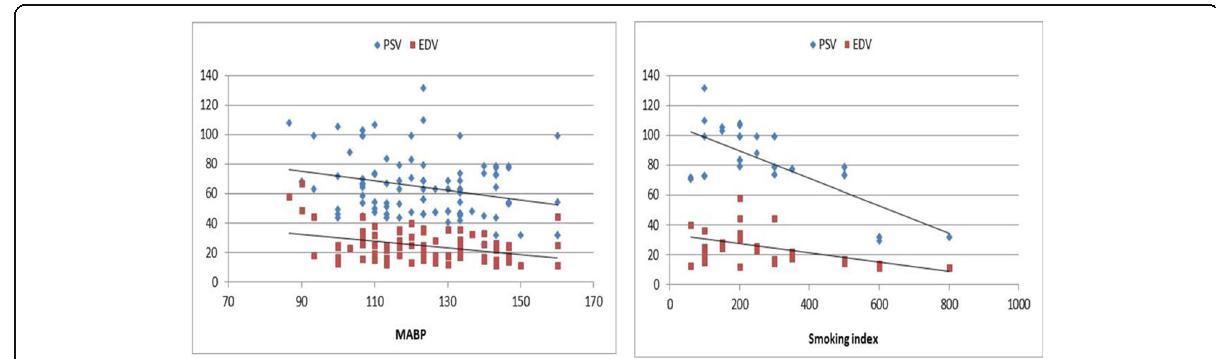
Fig. 1 Negative correlations between hypertension (MABP) and PSV and EDV (left) also negative correlations between smoking (smoking index) and PSV and EDV